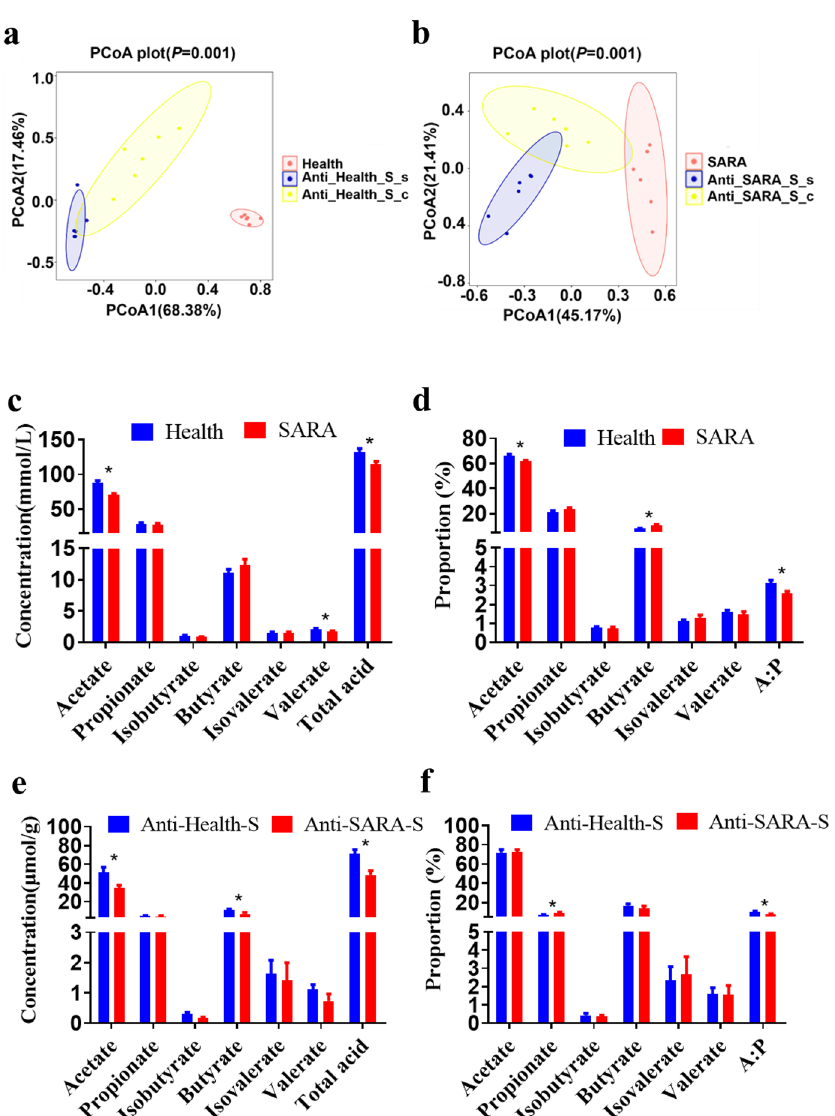
Fig. 6 The intestinal microbial composition and intestinal fermentation parameters alterations of antibiotic-treated mice were identi fi ed after ruminal microbe transplantation (RMT). a Principal coordinate analysis of mouse (infused by intragastric gavage with rumen fl uid from healthy dairy goats) intestinal bacterial community and donor (healthy dairy goats) rumen bacterial community based on the weighted UniFrac distance. b Principal Coordinate Analysis of mouse (infused by intragastric gavage with rumen fl uid from SARA dairy goats) intestinal bacterial community and donor (SARA dairy goats) rumen bacterial community based on the weighted UniFrac distance. The data of ( a ) and ( b ) were statistically analyzed based on the ANOSIM analysis. c The concentration and d relative proportion of VFA in the rumen of healthy and SARA donors. e The concentration and f relative proportion of VFA in colons from mice given a high starch diet after RMT in antibiotic- treated mice. The data for ( c – f ) were analyzed using the Students ’ t-test, and expressed as the means with the standard error. Anti: mice taking antibiotics; Health: mice infused by intragastric gavage with rumen fl uid from healthy dairy goats; SARA: mice infused by intragastric gavage with rumen fl uid from SARA dairy goats; S: high starch diet for mice; s: small intestine of mice; and c: mice colon. *Indicates the difference is at a signi fi cant level with p < 0.05, **indicates the difference is at a signi fi cant level with p < 0.01. Error bars on the graphs represent standard